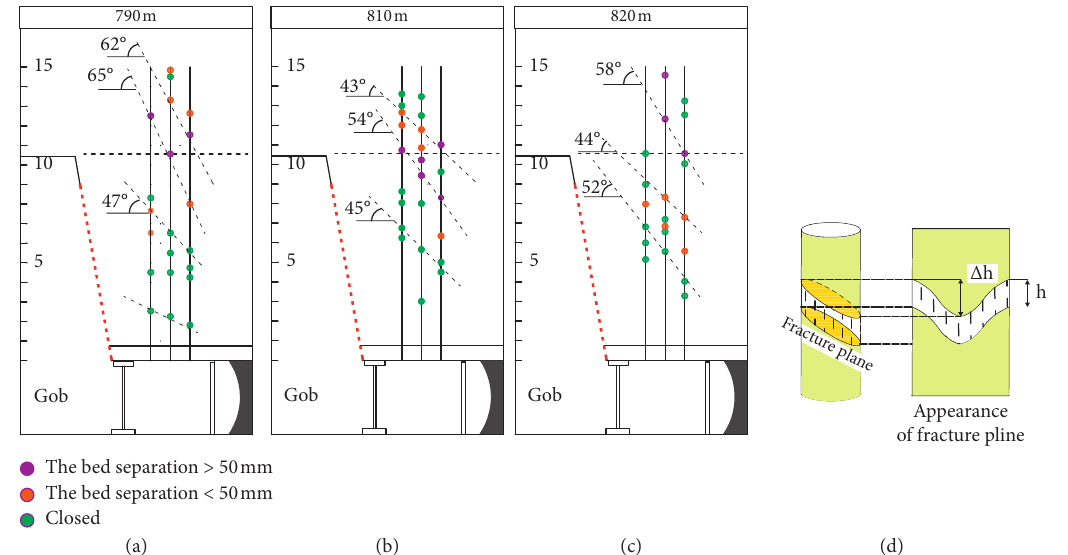
Figure 12: Borehole televiewer detection results of roof rock fracture zones: (a) the section with 790m offset from the open-off cut; (b) the section with 810m offset from the open-off cut; (c) the section with 820m offset from the open-off cut; (d) the principle of the borehole spreading pictures.